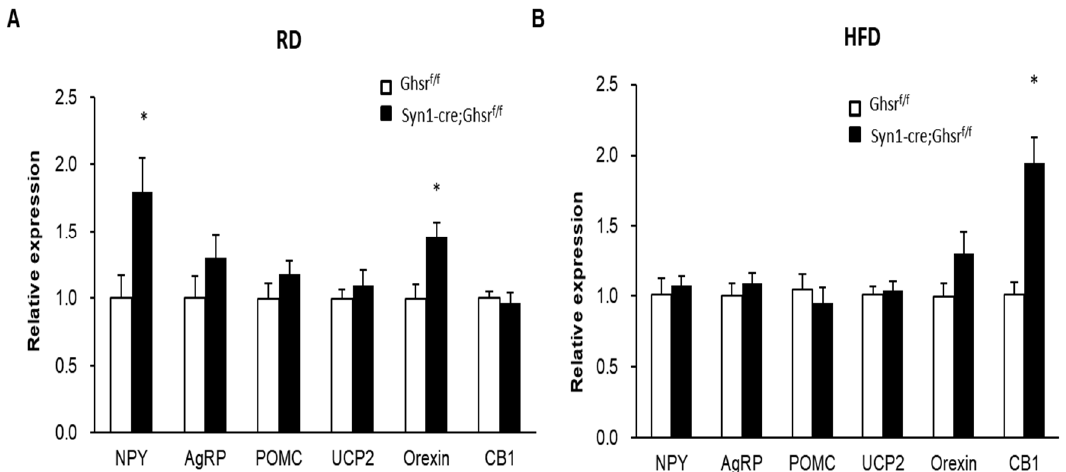
Figure 4. mRNA gene expression in the hypothlamsus of Syn1-Cre;Ghsr f/f and Ghsr f/f mice fed RD ( A ) and HFD ( B ). n = 5, * p < 0.05, Ghsr f/f vs. Syn1-Cre;Ghsr f/f . All data are presented as means ± SEM.